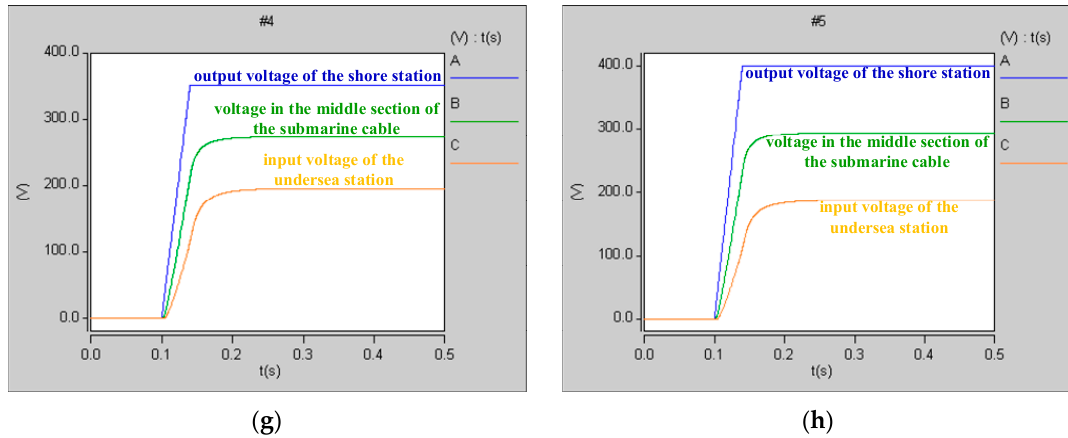
Figure 8. ( a ) The voltage transient processes in the parameter set #1; ( b ) the current transient processes in the parameter set #1; ( c ) the voltage transient processes in the parameter set #2; ( d ) the current transient processes in the parameter set #2; ( e ) the voltage transient processes in the parameter set #3; ( f ) the magnified view of voltage transient processes in the parameter set #3; ( g ) the voltage transient processes in the parameter set #4; ( h ) the voltage transient processes in the parameter set #5.